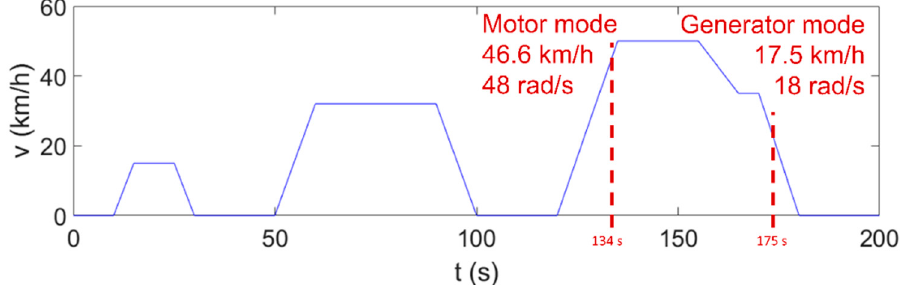
Figure 22. Working points selected in the ECE-15 driving profile to evaluate the input impedance of